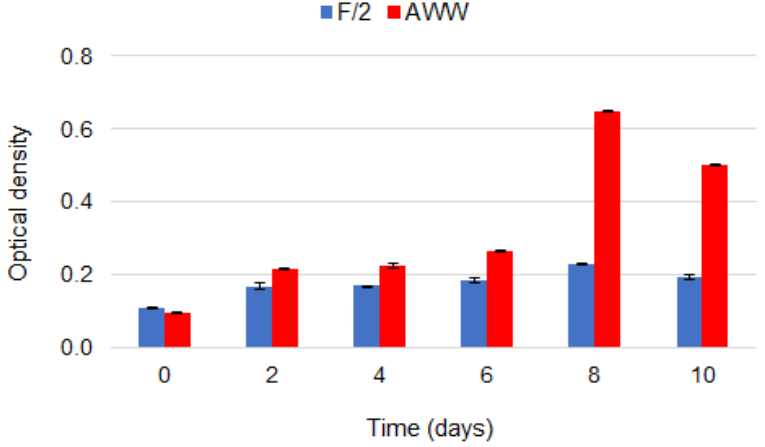
Figure 4. Changes observed in the optical density during the cultivation of Monoraphidium sp. (mean ± SD; F/2—synthetic medium, AWW—aquaculture